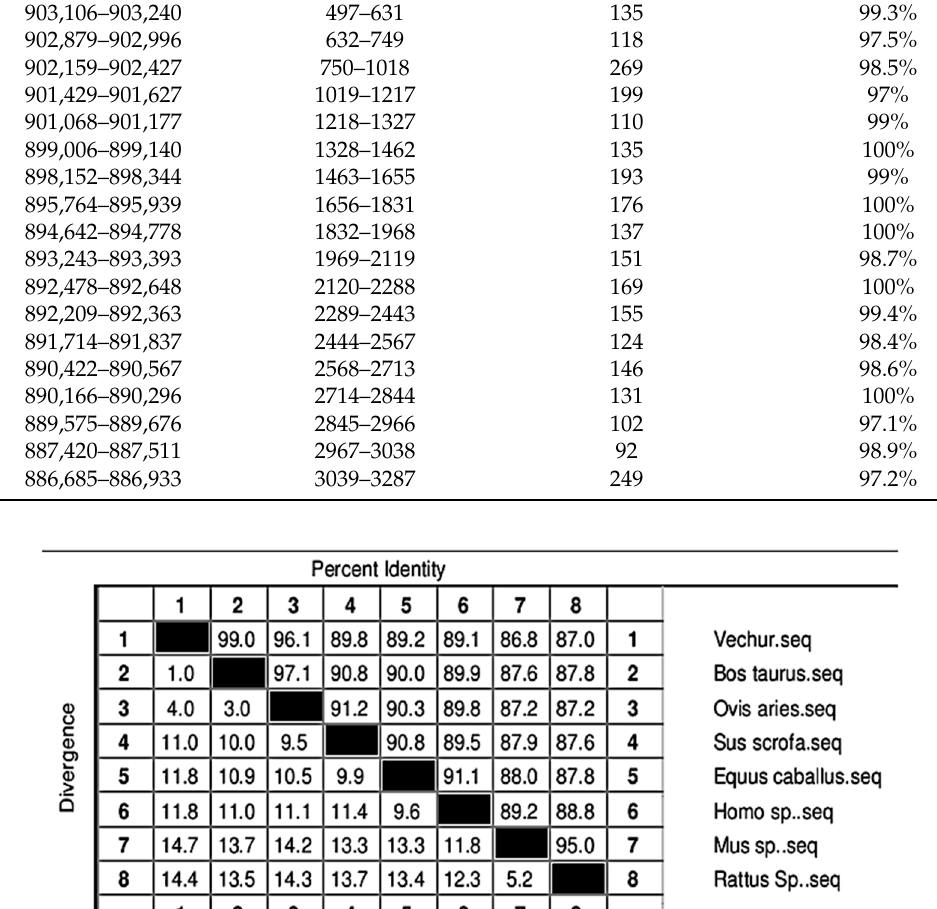
Figure 4. Percent identity (upper half) and divergence (lower half) of the ATP1A1 gene of Vechur cattle with similar sequences in the database.